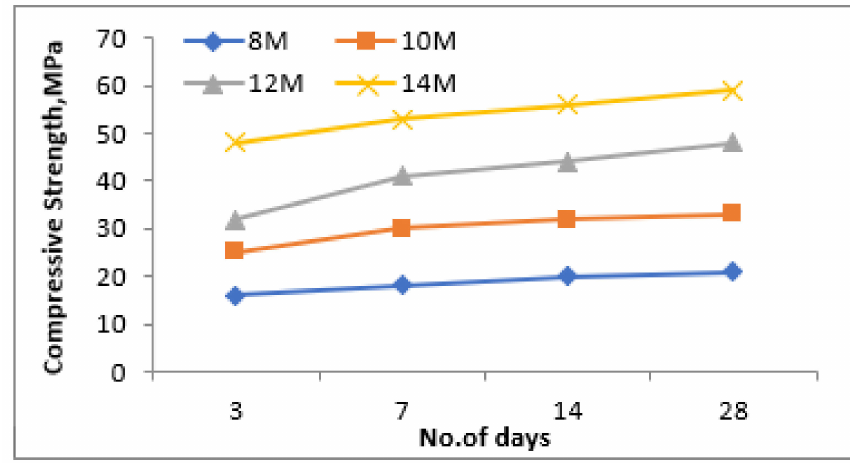
Figure 7. Compressive strength for different molarities of NaOH.